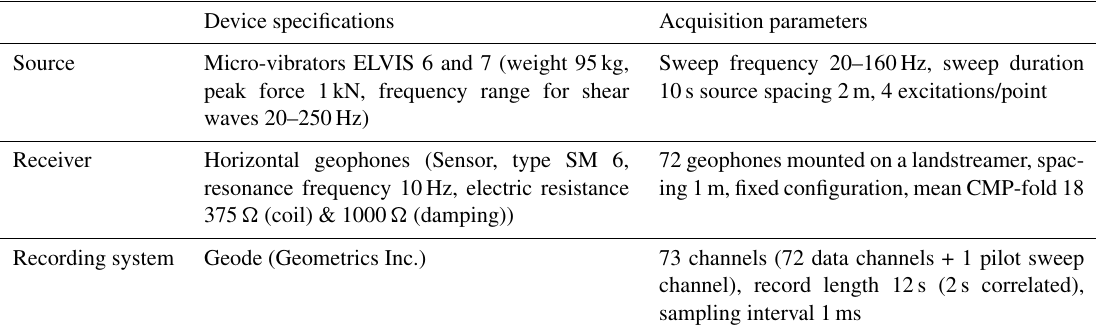
Table 1. Device and acquisition parameters of the seismic source, the receivers, and the recording